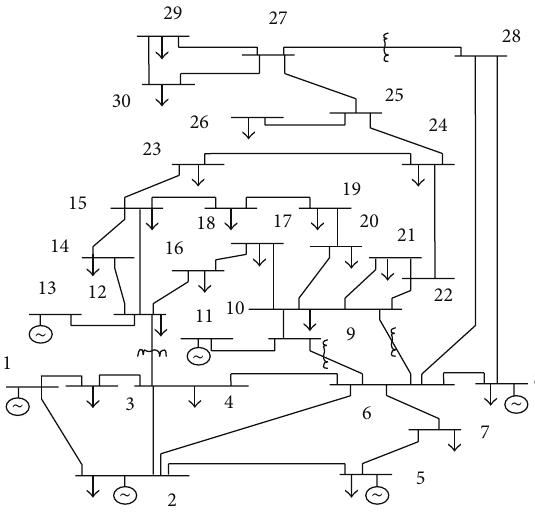
Figure 2: Single line diagram of IEEE 30-bus test